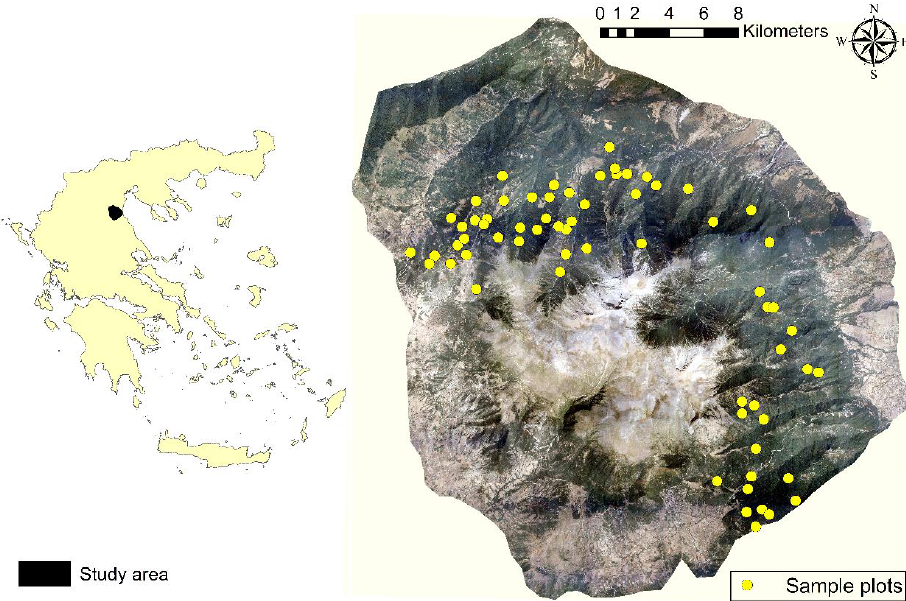
Figure 1. Study area location map and distribution of the sample plots.